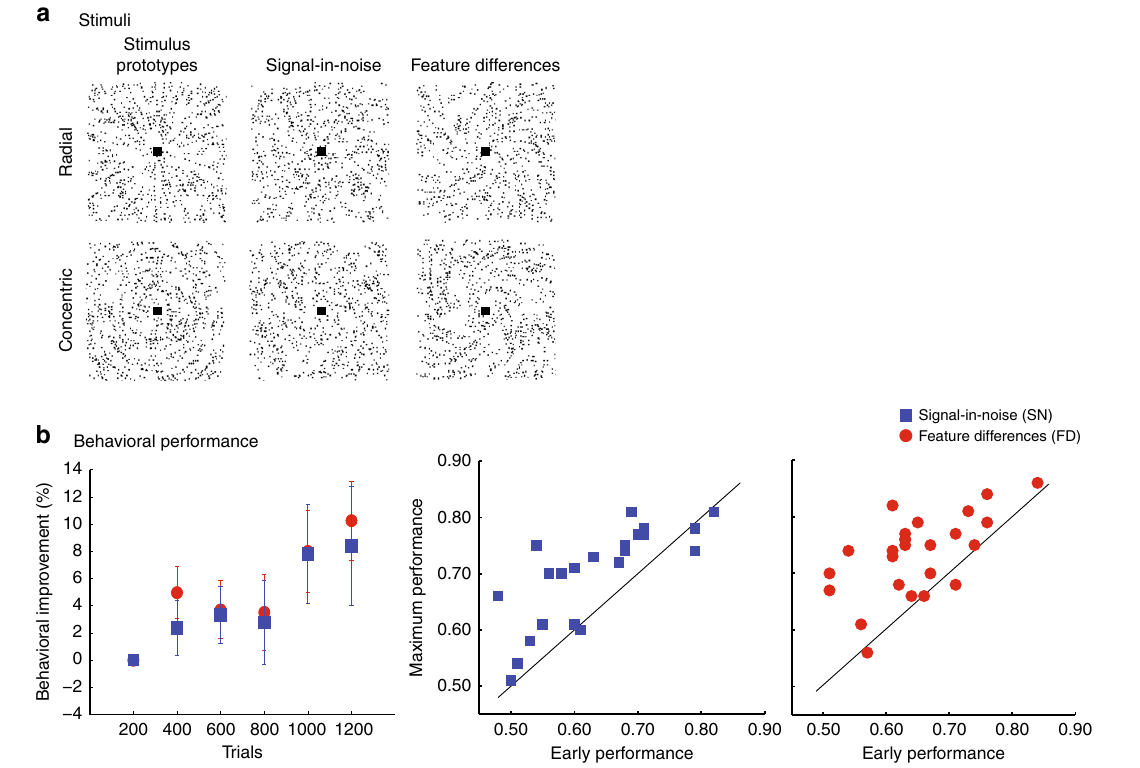
Fig. 1 Tasks, stimuli, and behavioral results. a Stimuli: Example stimuli comprising radial and concentric Glass patterns (stimuli are presented with inverted contrast for illustration purposes). Stimuli are shown for the signal-in-noise task (SN task, 25% signal, spiral angle 0° for radial and 90° for concentric) and the feature differences task (FD task, 100% signal, spiral angle 38° for radial and 52° for concentric). Prototype stimuli (100% signal, spiral angle 0° for radial and 90° for concentric) are shown for illustration purposes only. b Behavioral performance across participants: We calculated improvement in task performance during training as the difference in mean performance (i.e., mean accuracy) during each training block (200 trials) from the fi rst training block (200 trials), divided by performance in the fi rst training block. Further, we compared individual participant accuracy early in training ( fi rst 200 trials) to the maximum accuracy achieved per participant during training (200 trials). Participants did not differ signi fi cantly in their performance early in training ( t (45) = 0.56, p = 0.57) between the two tasks. Note that most participants (85%) achieved maximum performance during the last two MRS measurements. Error bars indicate standard error of the mean across